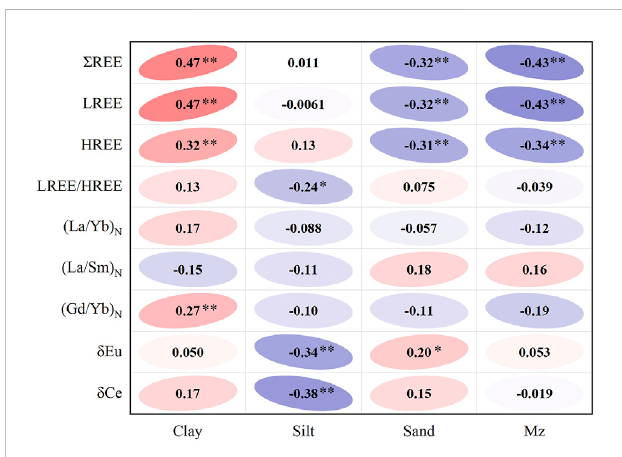
The correlations between grain size indicators and rare earth elements parameters. The red and blue represent positive and negative correlations;thehigher thecorrelation coef fi cient, thedarker thecolour and the larger the angle; ** and * express signi fi cant correlations at the 0.05 and 0.01 levels (2-tailed).